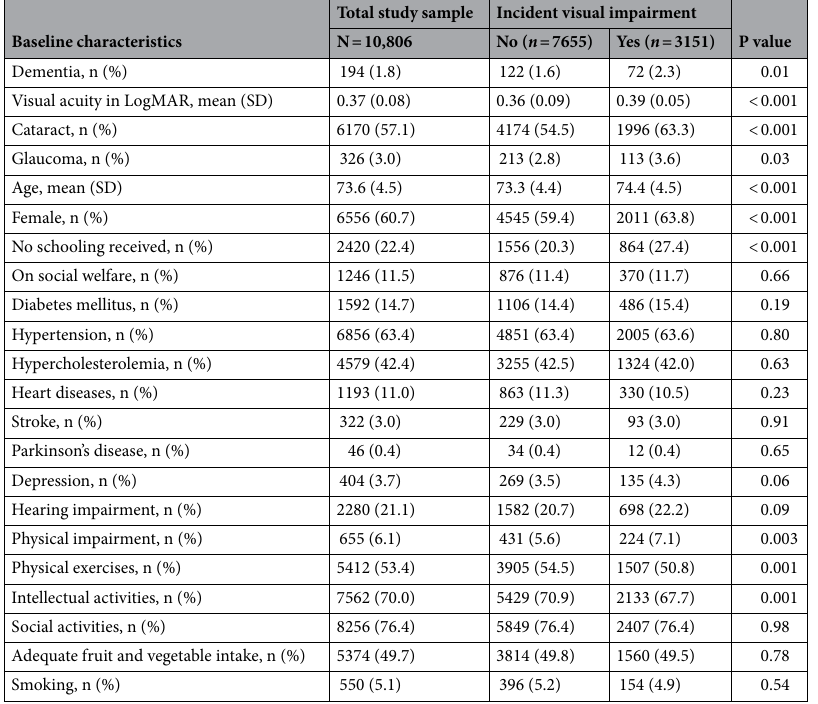
Table 1. Comparison of baseline characteristics between participants with and without incident visual impairment over 6 years.